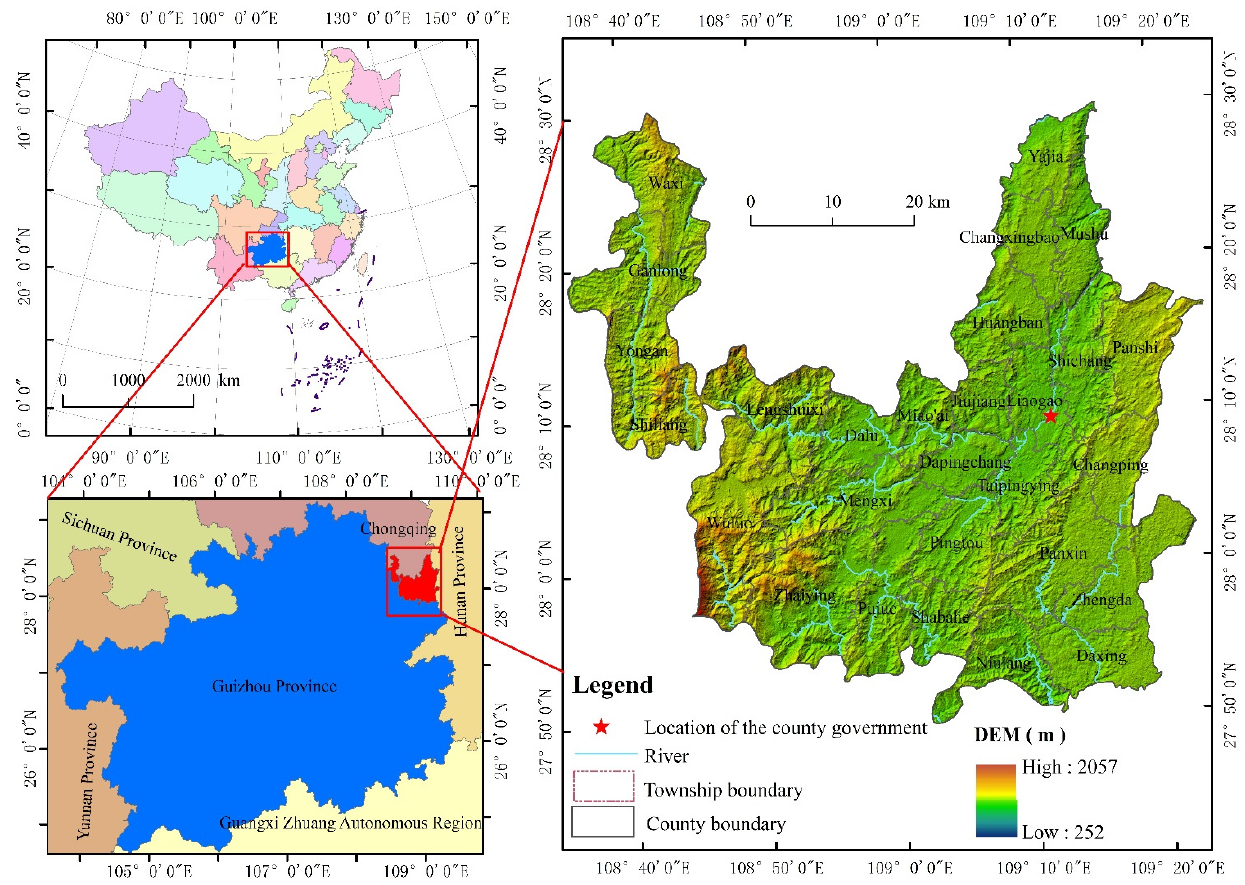
Figure 1. Location and topography of study area.